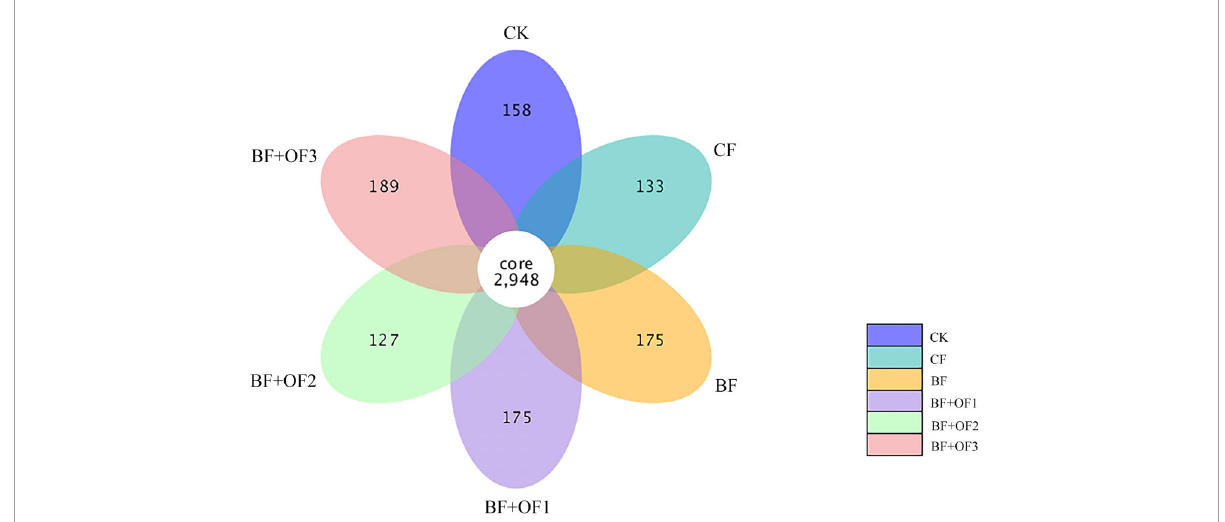
FIGURE2 Petal plot of soils with different fertilization treatments based on operational taxonomic unit (OTU) distribution. CK, no fertilizer, CF, chemical fertilizers (conventional dosage for this region); BF, balanced fertilizer (70% of total chemical fertilizer); BF + OF1, BF + OF2, and BF + OF3,